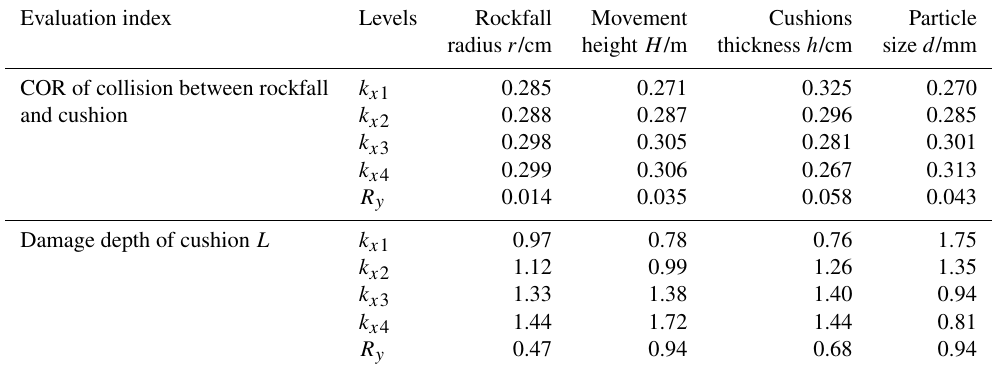
Table 6. Range analysis of two influencing factors for all evaluation